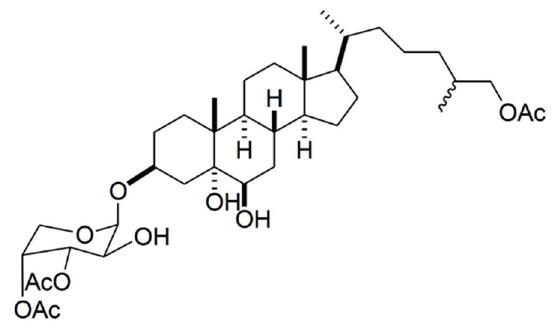
Figure 16. Carijoside A ( 80 ), isolated from Carijoa sp.